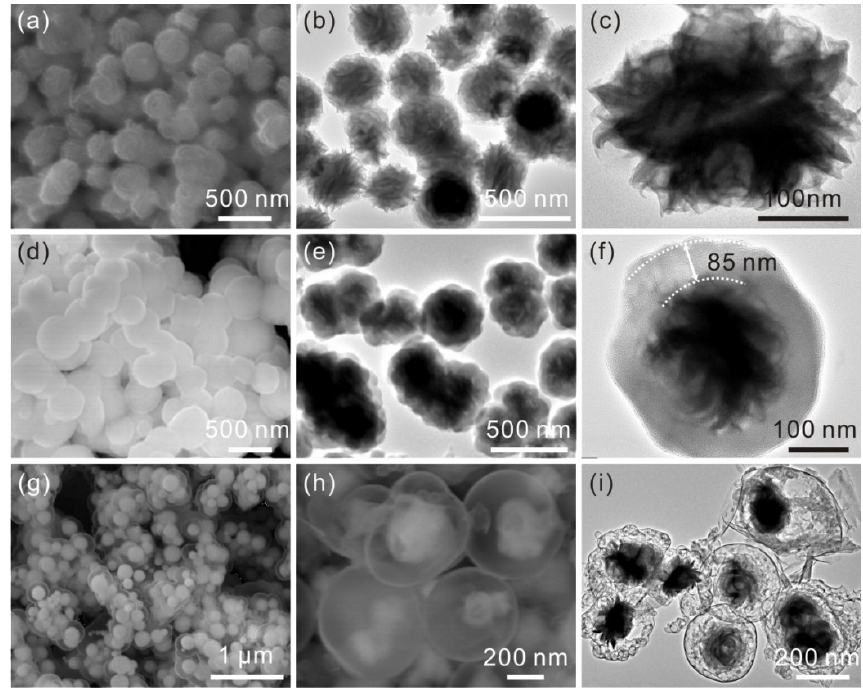
Figure 3. SEM and TEM images of ( a – c ) the MoS 2 microspheres, ( d – f ) the MoS 2 @SiO 2 microspheres,